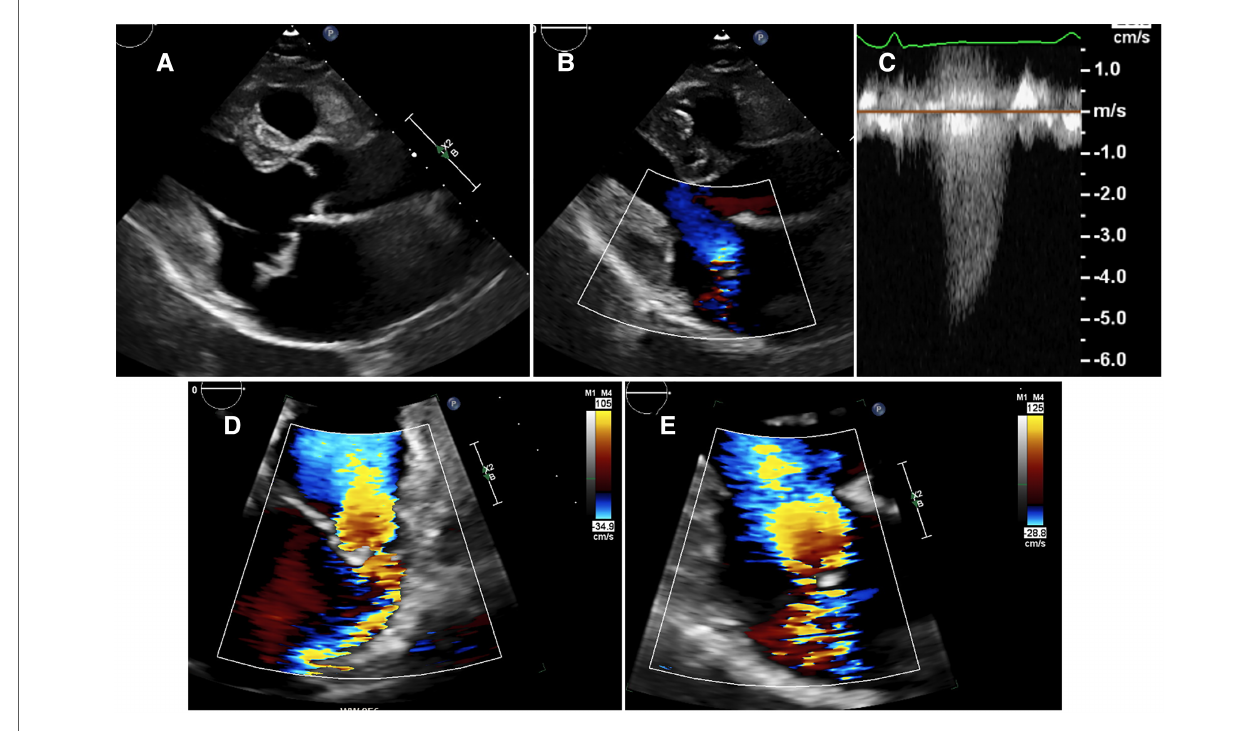
FIGURE 4 Patient with primary MR with typical features of Barlow ’ s disease. Presence of a MV valve prolapse (A3P3) with mitral annulus dilatation and disjunction ( A ). The MR jet is very eccentric with small color jet size ( B ). The best CWD MR envelope is obtained in the long-axis parasternal view, revealing a mid-late systolic MR ( C ). Using the PISA method, the proximal fl ow convergence area displays an oblong shape in apical-4-chamber view because being constrained by the LV lateral wall ( D ). The proximal fl ow fi eld is better delineated in long-axis parasternal view ( E ), with an “ urchinoid ” shape because of loss of Doppler signal on its angles. CWD, Continuous-Wave Doppler; LV, left ventricular; MR, mitral regurgitation; MV, mitral valve; PISA, proximal isovelocity surface